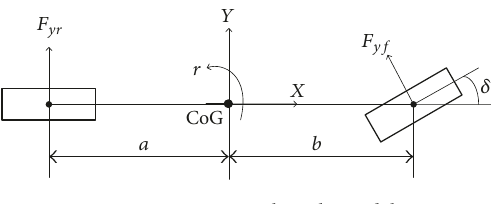
Figure 1: Dynamic bicycle